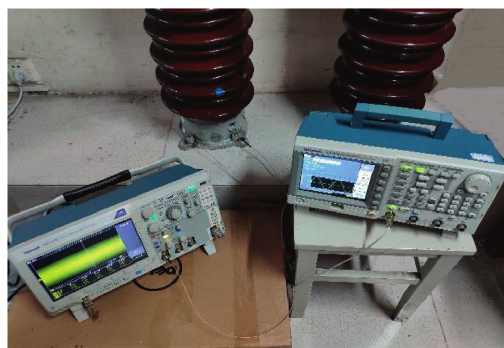
Figure 10: Harmonic excitation experiment.